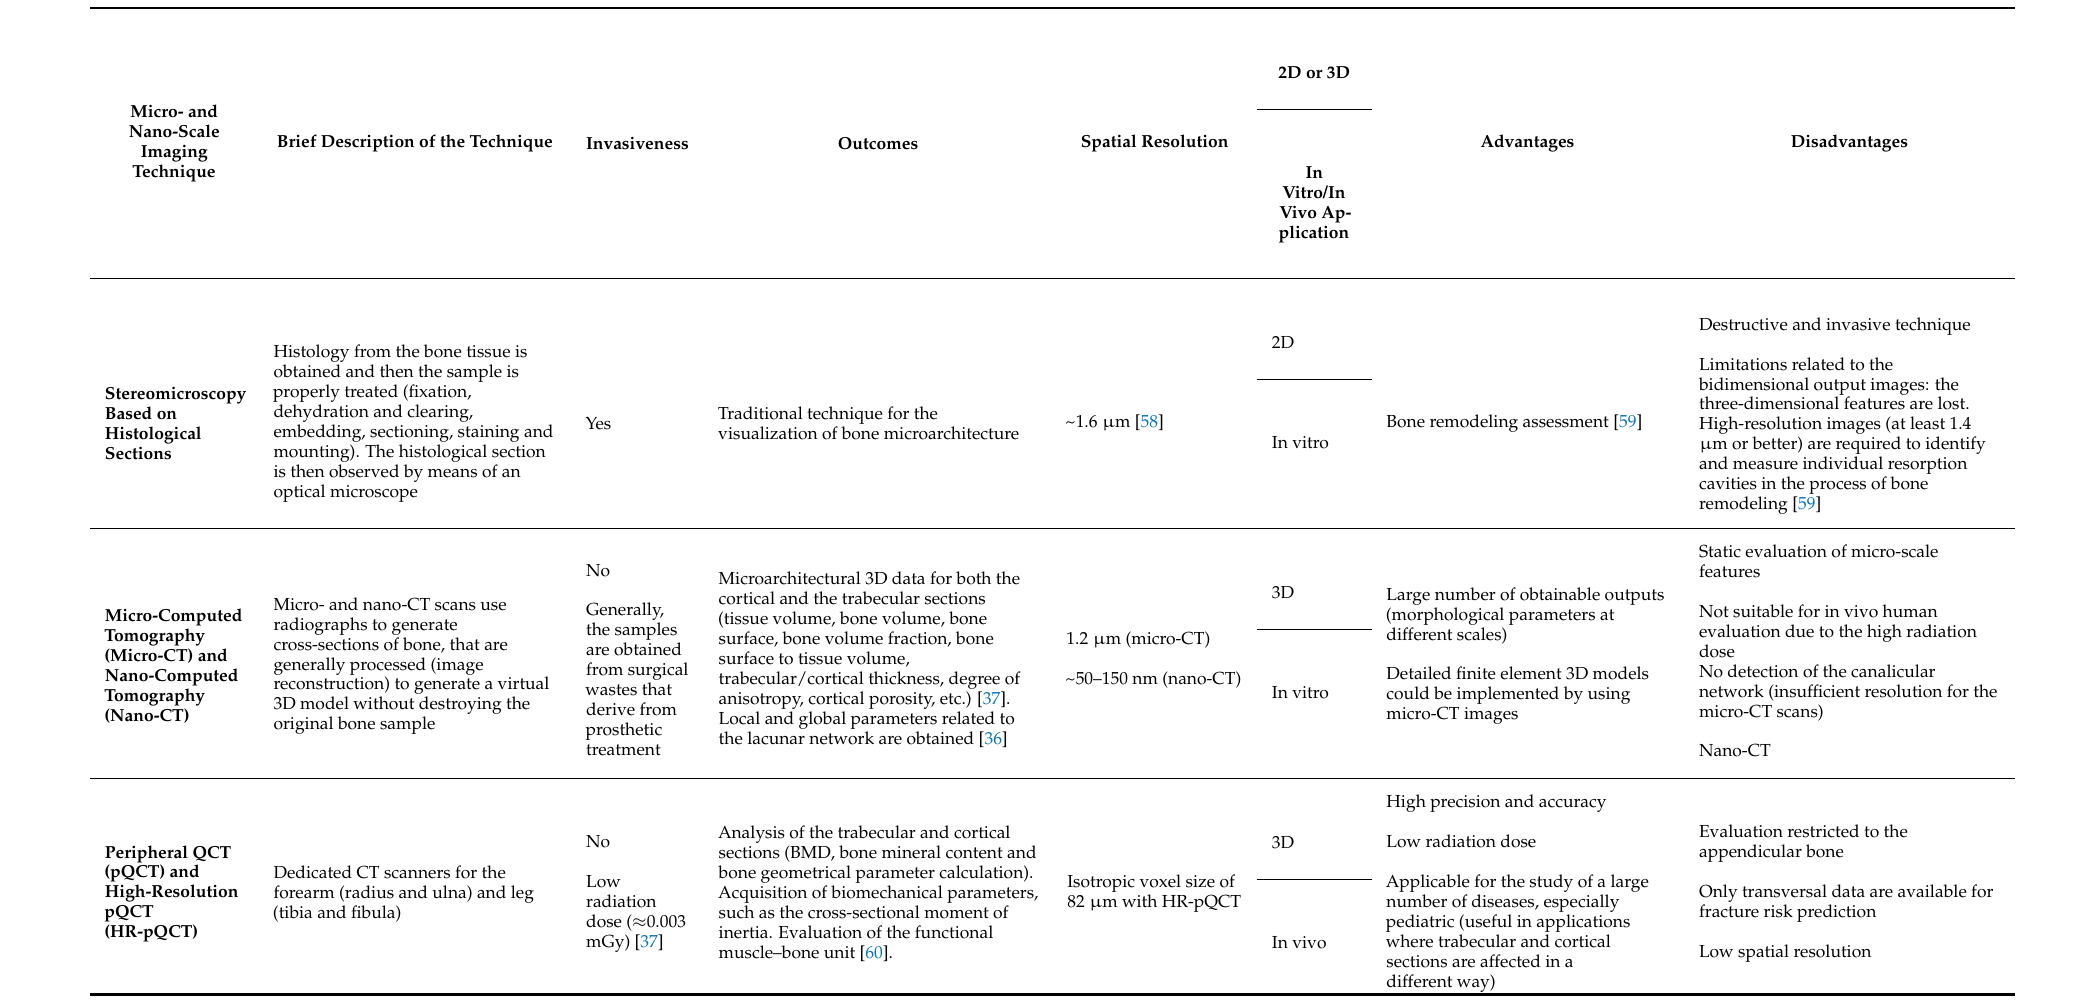
Table 2. Overview of the main micro- and nano-scale imaging